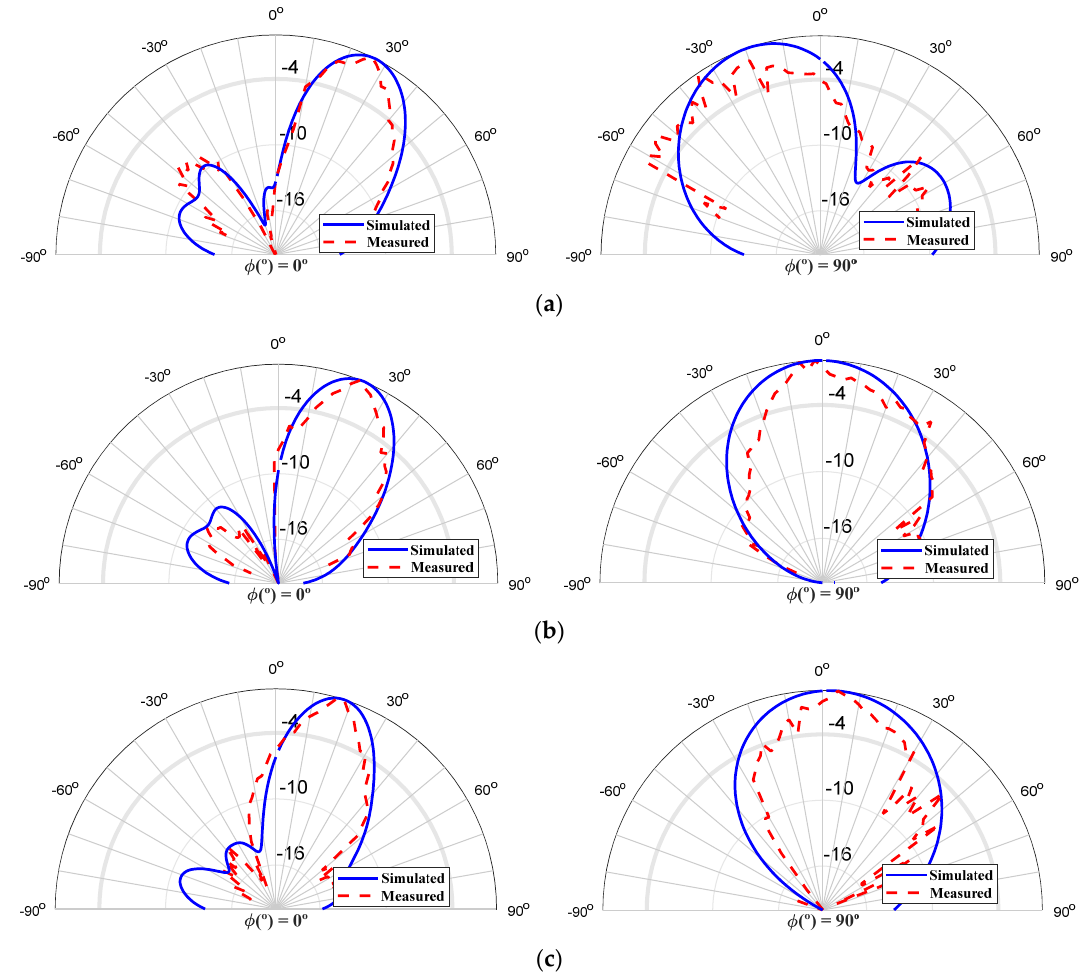
Figure 12. Radiation pattern of the 9-element log-periodic microstrip antenna array in the two main planes φ = 0 ◦ and φ = 90 ◦ , for different frequencies: ( a ) f = 27 GHz; ( b ) f = 28 GHz; and ( c ) f = 29